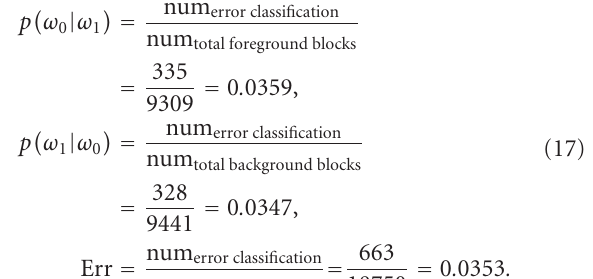
Table 4: Segmentation time in P4 2.4GHz PC for each DB (sec-